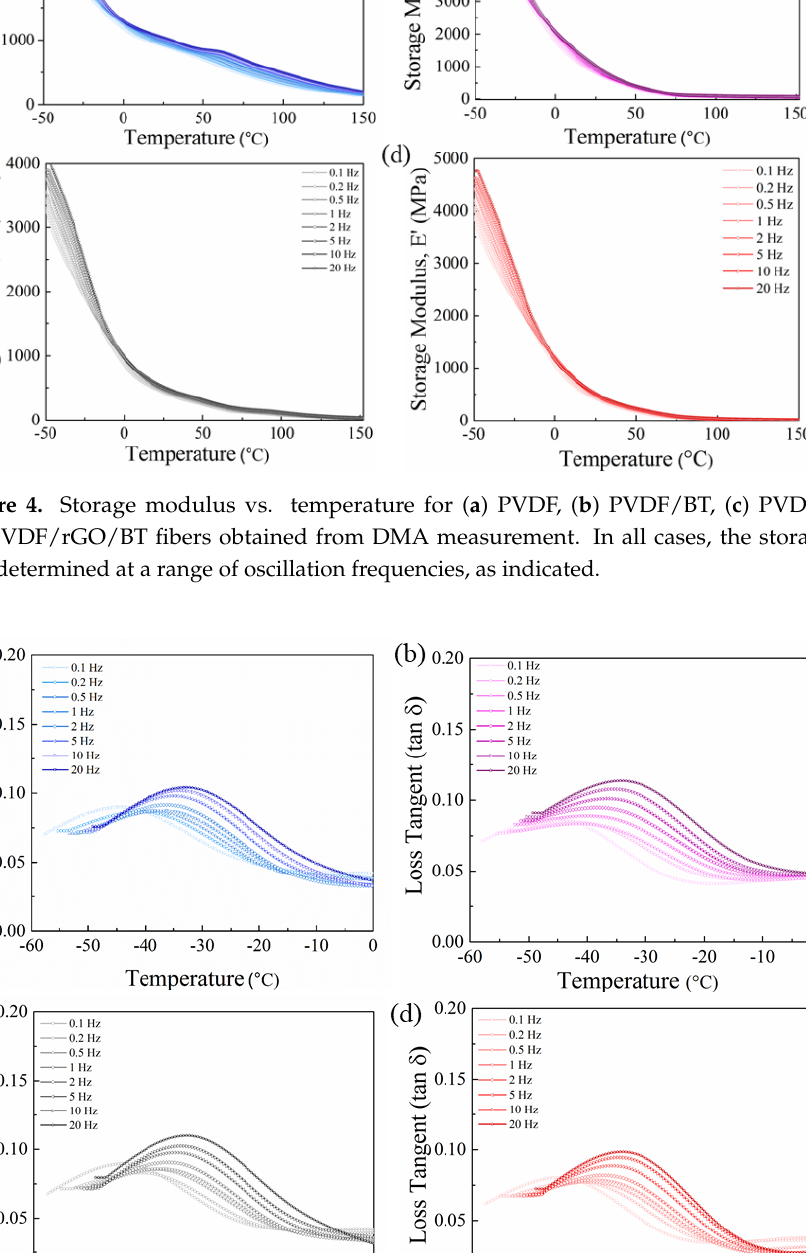
Figure 5. Temperature and frequency dependence of tan δ for ( a ) PVDF, ( b ) PVDF/BT, ( c ) PVDF/rGO, and ( d ) PVDF/rGO/BT nanofibers.